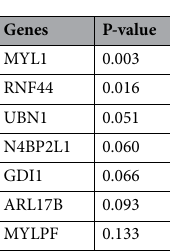
Table 7. Top 10 significant genes that were aggregated by the RobustRankAggreg tool for the GDS2545 dataset.